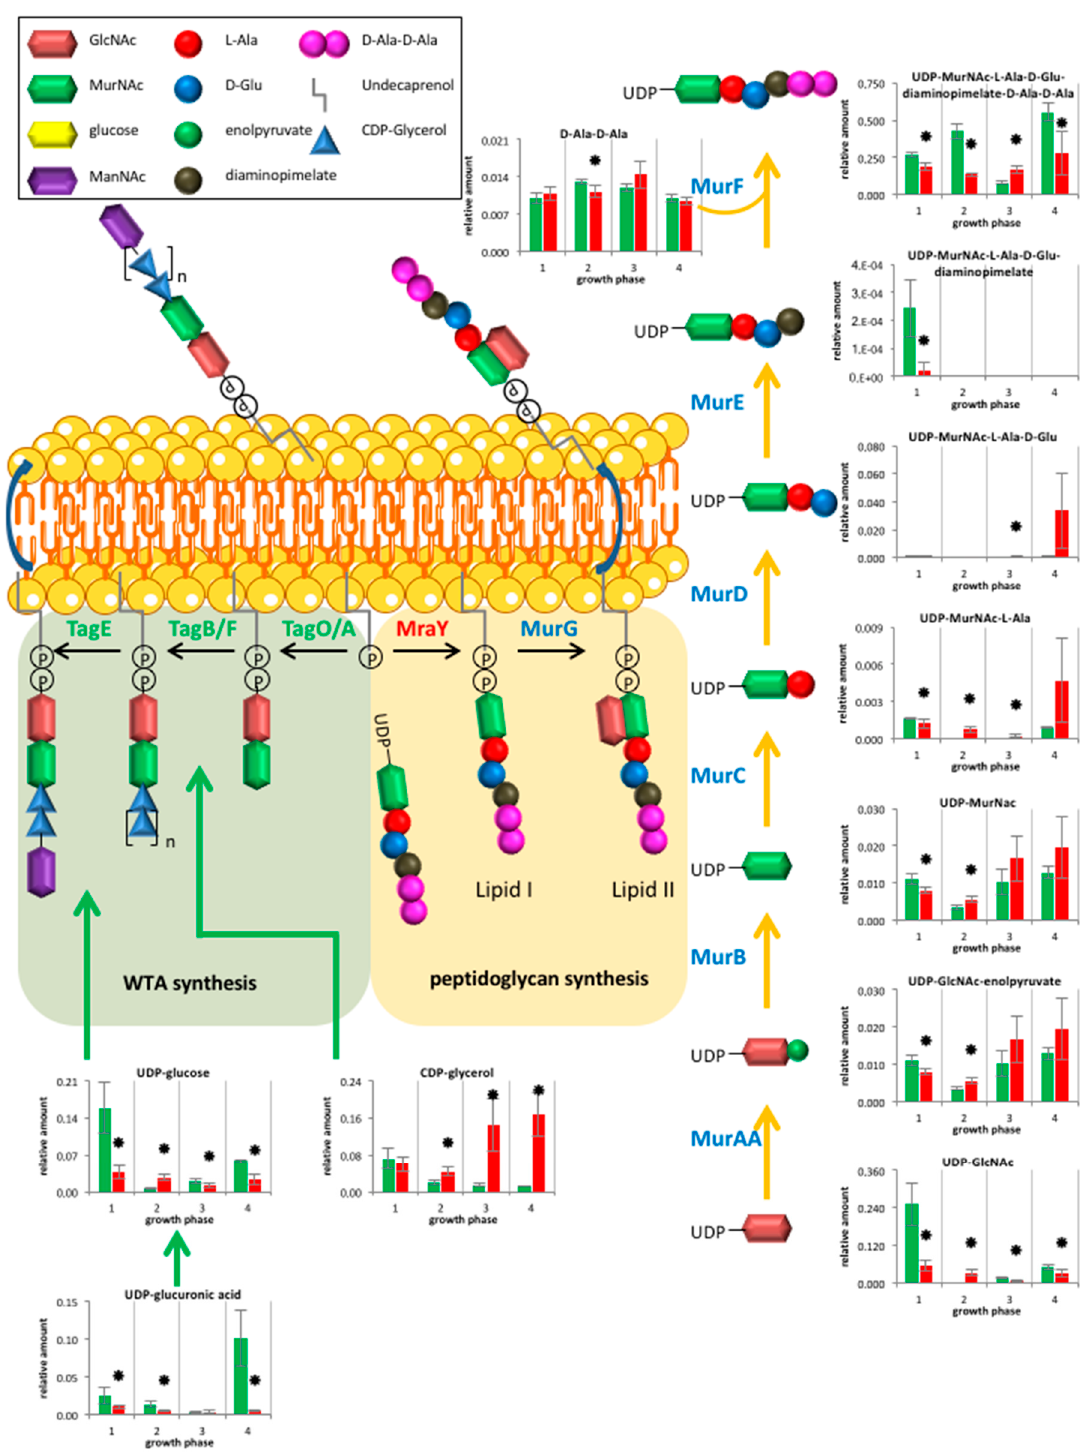
Figure 4 Figure 4. Overview of metabolites from peptidoglycan and Wall teichoic acids (WTA) synthesis for wild type (green) and clpP mutant (red) from the exponential growth phase (1), the transient (2), the early stationary (3) to late stationary growth (4). Data are shown for four biological replicates. Asterisks indicate significant changes ( p value ≤